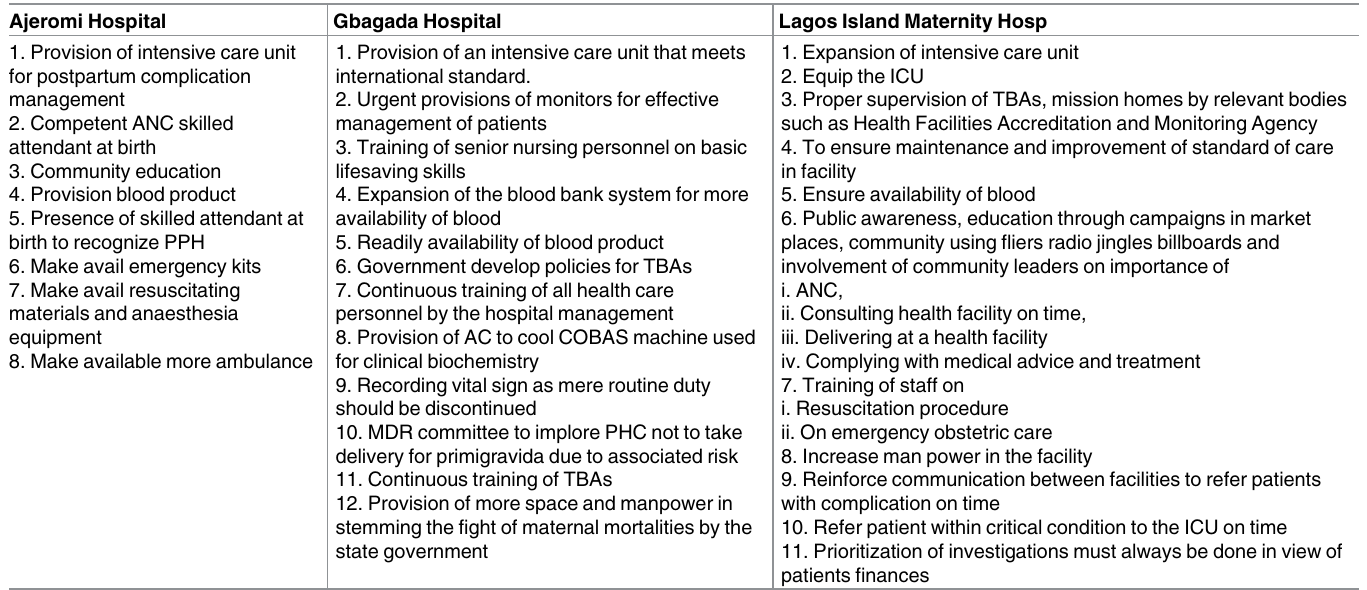
Table 5. Recommendations on preventing maternal deaths by health